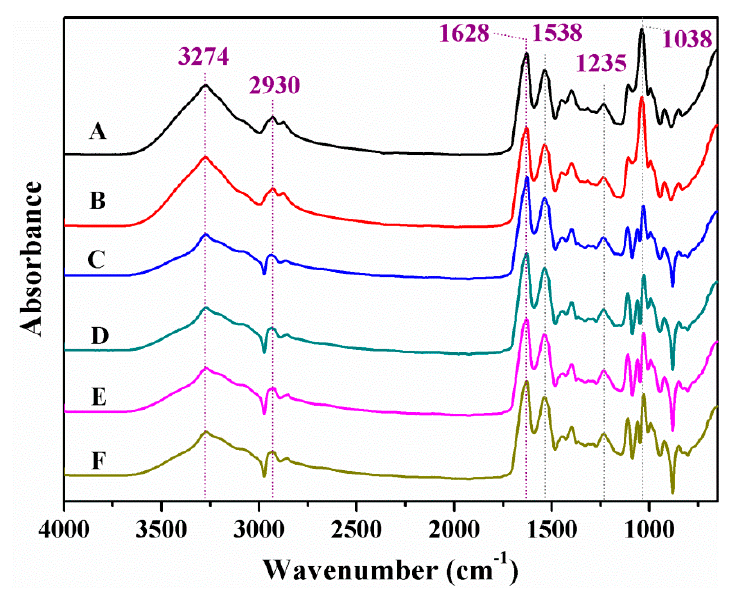
Figure 3. ATR FT-IR spectra of different SPI-based films.